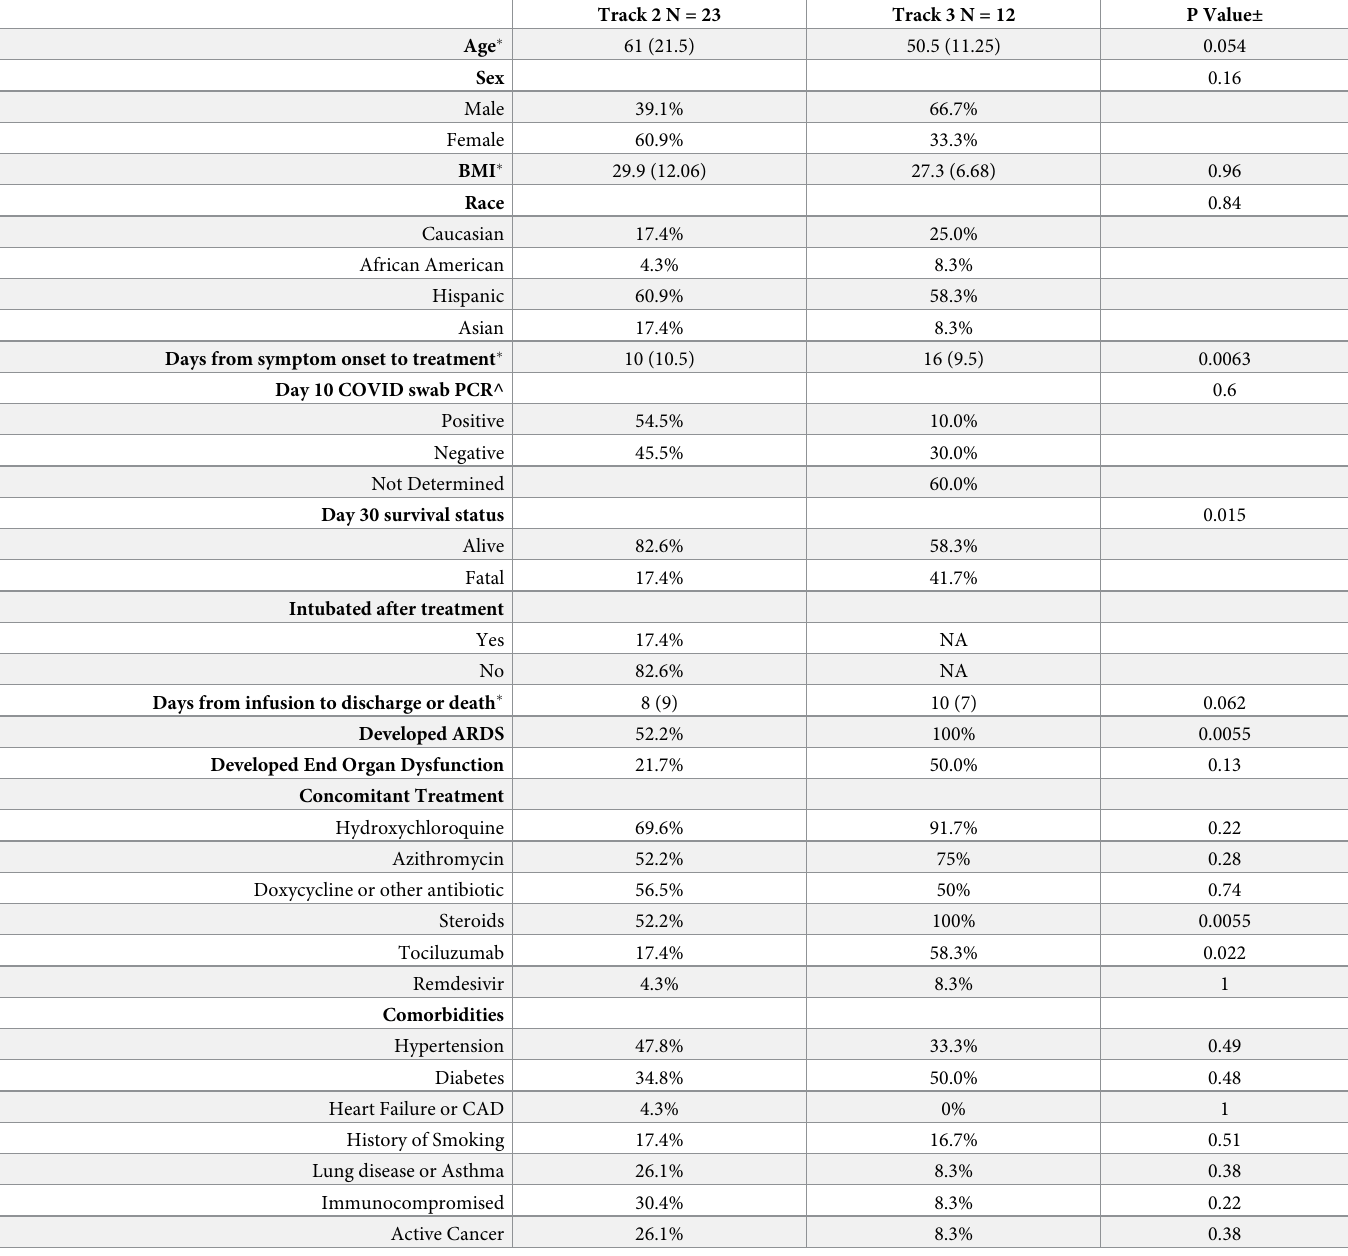
Table 3. Recipient